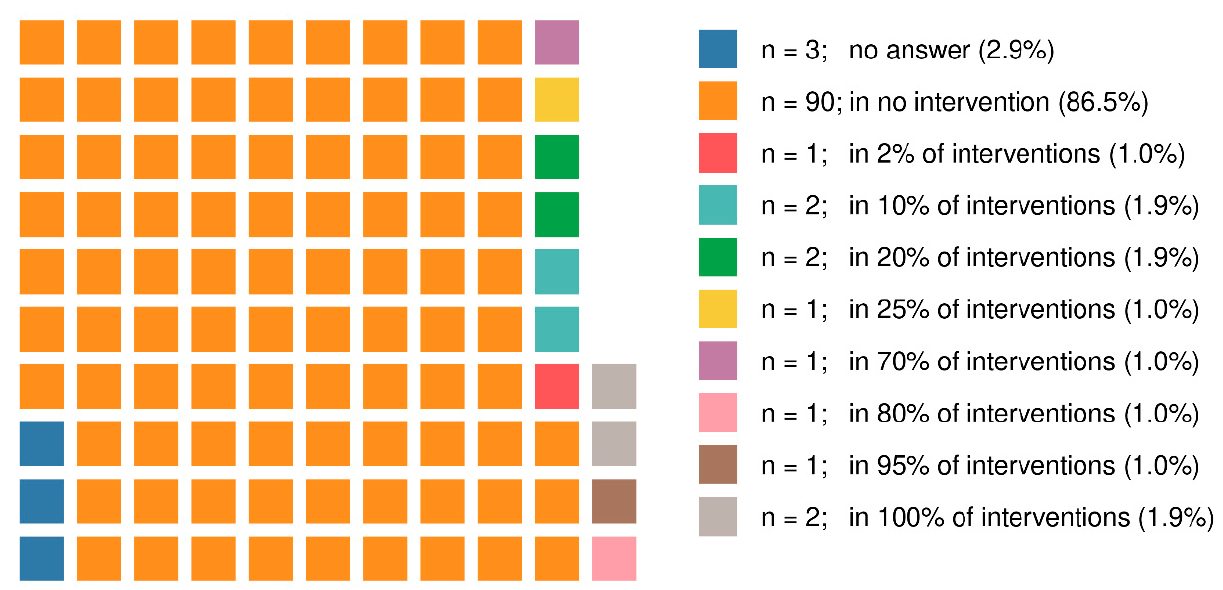
Figure 2. Location of the X-ray tube above the table; percentage of procedures ( n = 104).